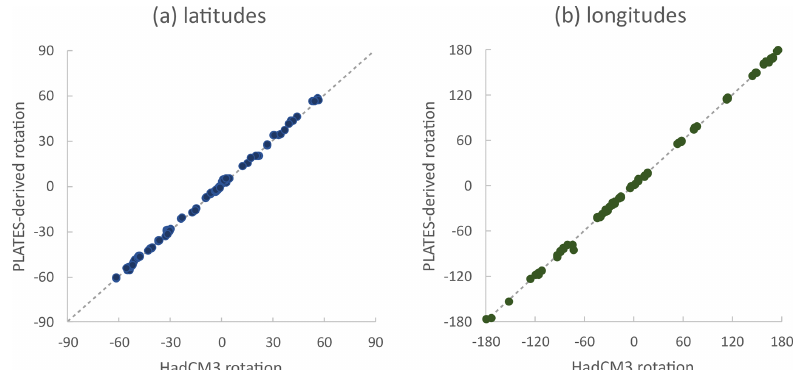
Figure B1. Comparison of PLATES-derived rotation (applied to the full data set) to the HadCM3 rotation (used as a basis for the cGENIE model). The mean difference between PLATES and HadCM3 palaeo-locations for latitude is 0.216 ◦ (standard deviation of 1.14 ◦ ), whereas for longitude, the mean difference is − 0 . 498 ◦ (standard deviation of 1.80 ◦